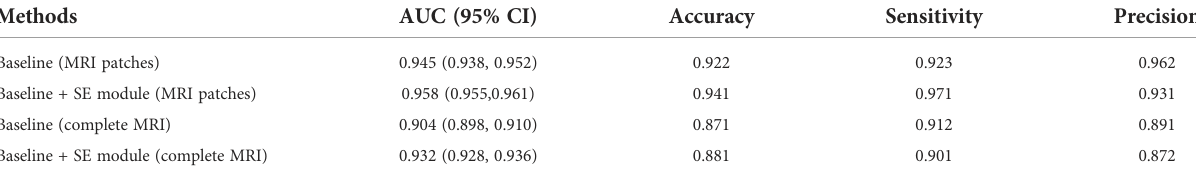
TABLE 1 The experimental results of tumor grading using combination of CNN and radiomics